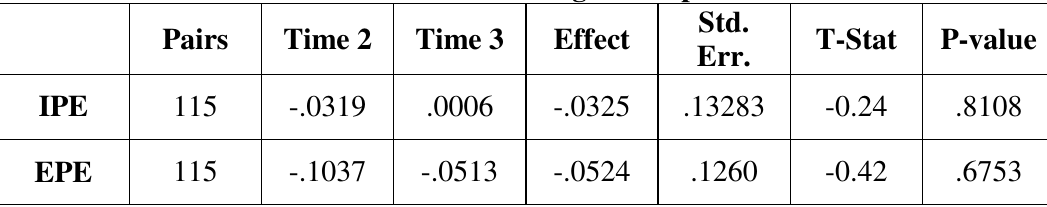
Table 8: PSM Results - IPE and EPE among Participants at Time 2 and Time